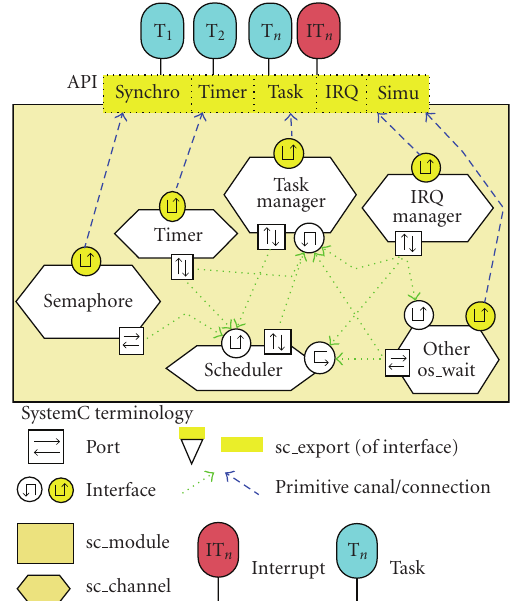
Figure 6: The modular RTOS model and its composed API. Each OS service exports its own interface to the application. Services are connected together to ensure the global OS coherency and